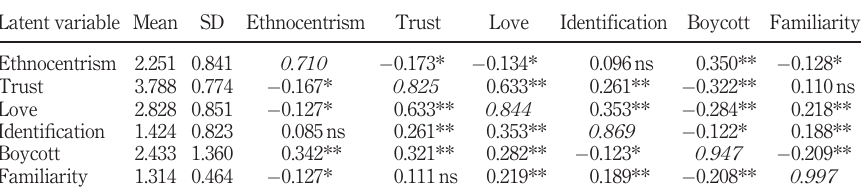
Table 3. Correlation matrix of latent variables and descriptive statistics